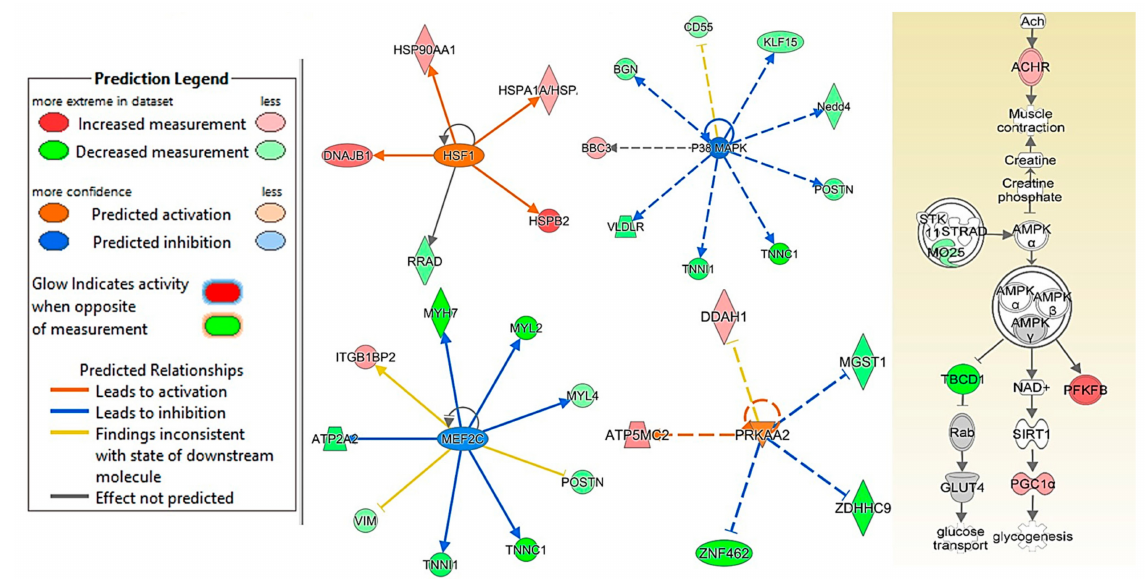
Figure 5. HSF1, p58, MAPK and AMPK signaling. CDN treatment prevented the age-associated alterations in the HSF1, P38 MAPK, MEF2C, PKAA2, and APMK signaling pathways in the gastrocnemius muscles of 26-month old mice, when compared to vehicle treated mice ( n = 8–9 mice/group). Upstream regulator analysis of HSF1, P38 MAPK, MEF2C, and PKAA2, while pathways analysis of AMPK is shown. The solid lines show the known direct effect, while the dashed lines show known indirect